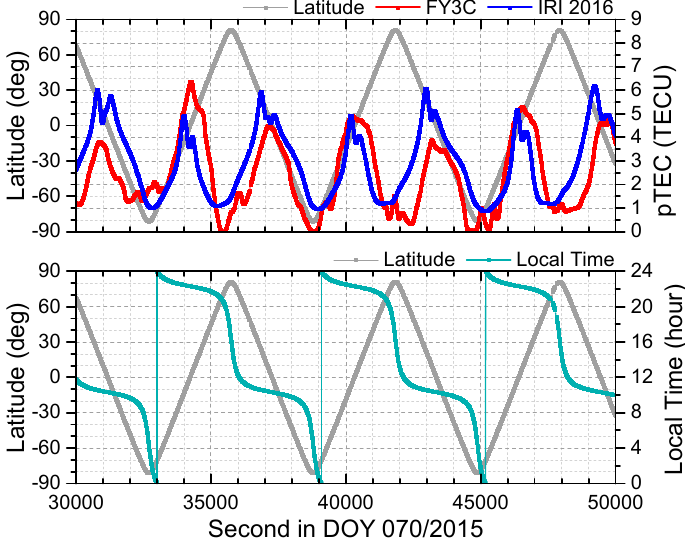
Figure 8. FY3C-based and IRI 2016 model pTEC series during DOY 070/2015: ( Top ) the pTEC variations associated with satellite latitude along FY3C orbit tracks; and ( Bottom ) the latitude and local time during the selected period.